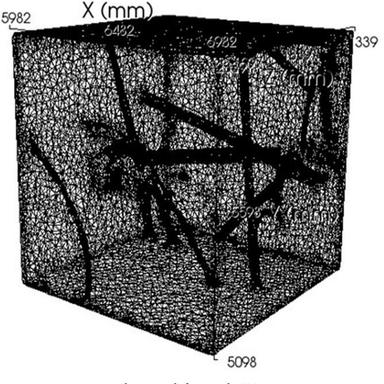
Mesh for sample 409.